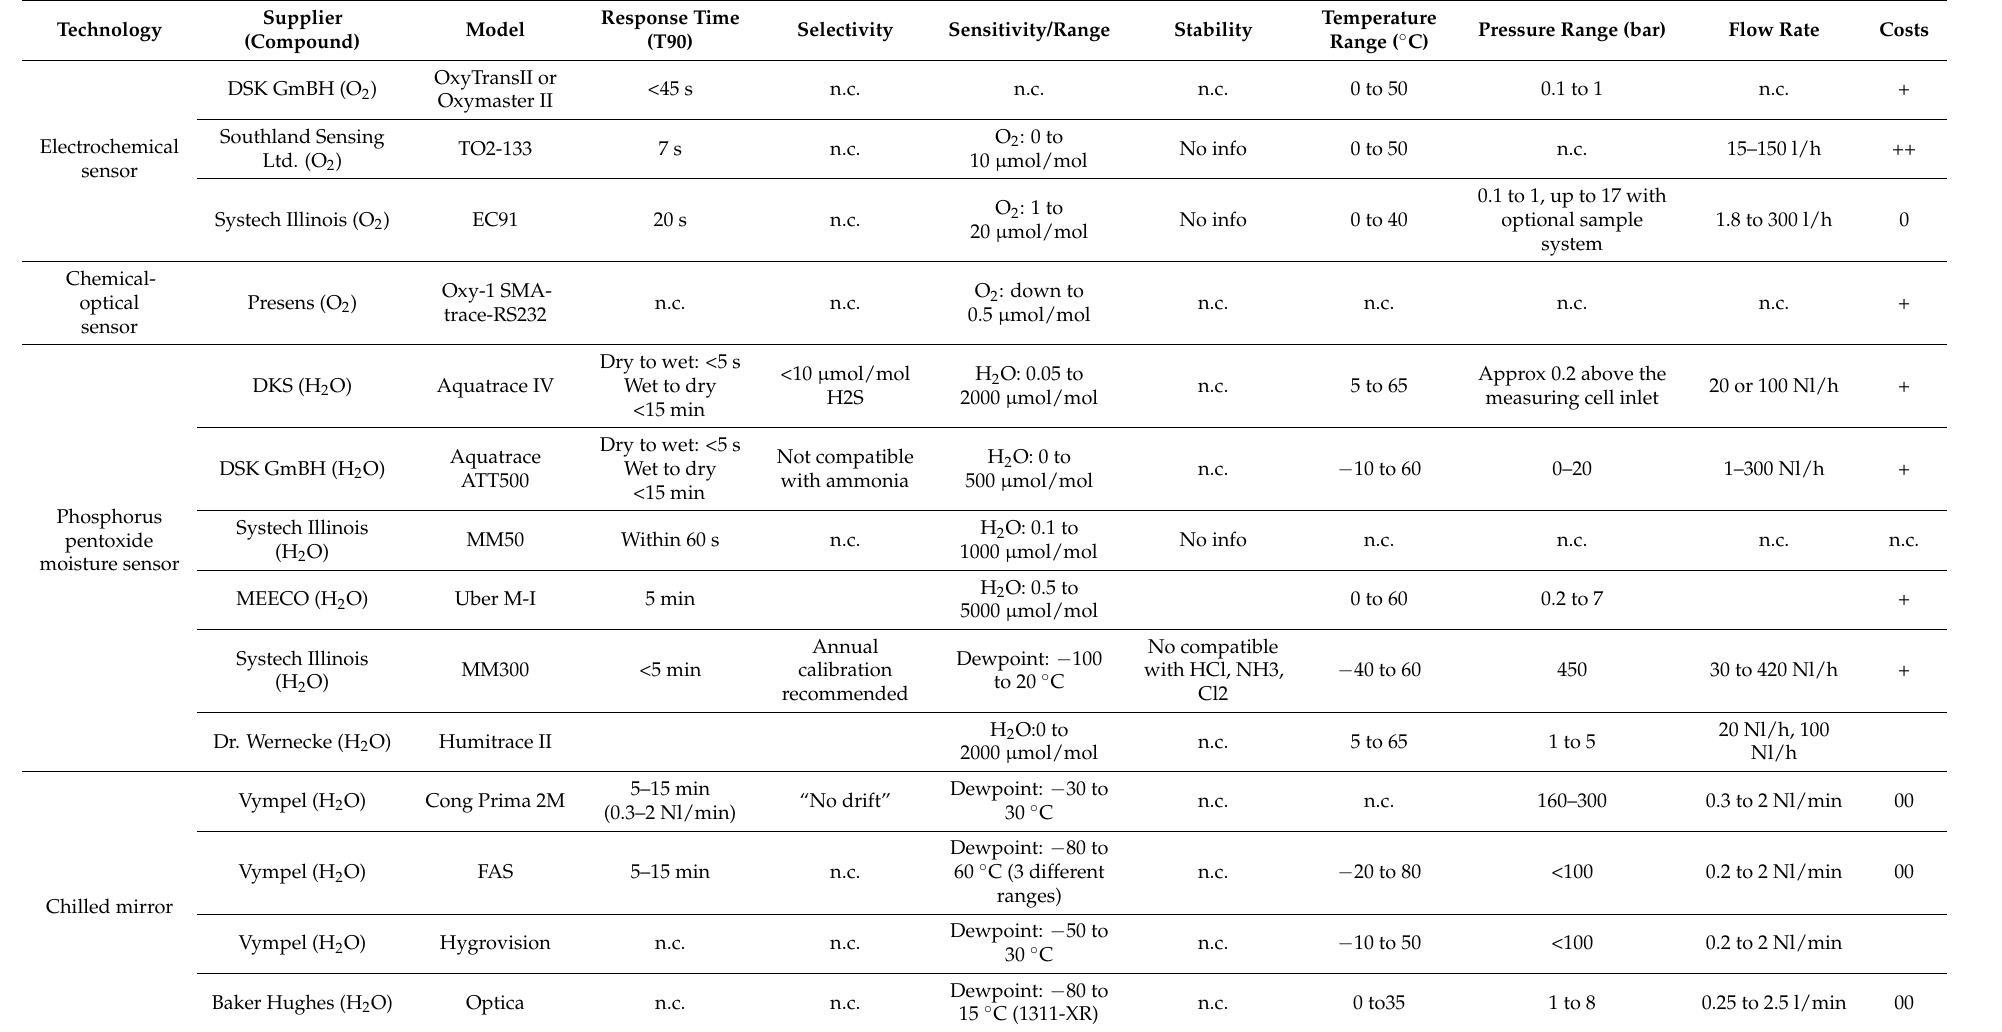
Table 1. Information about available sensors for impurities in hydrogen classified by